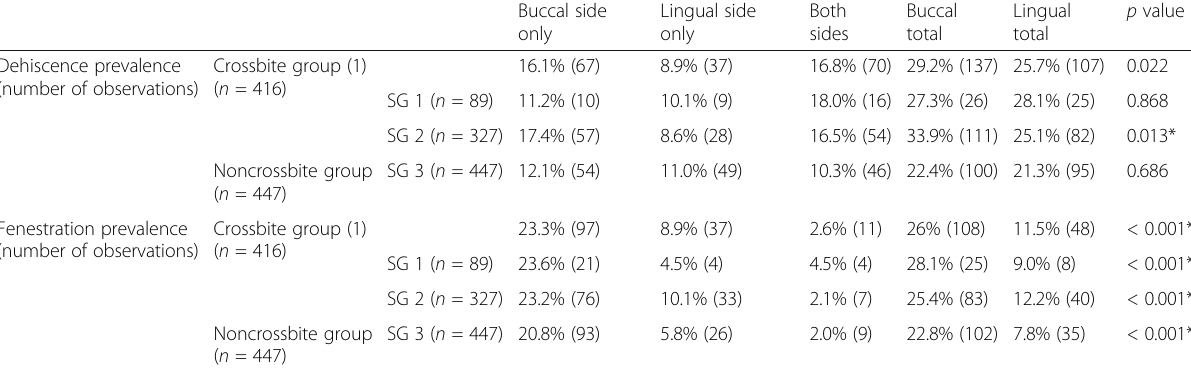
Buccal side Lingual side only only